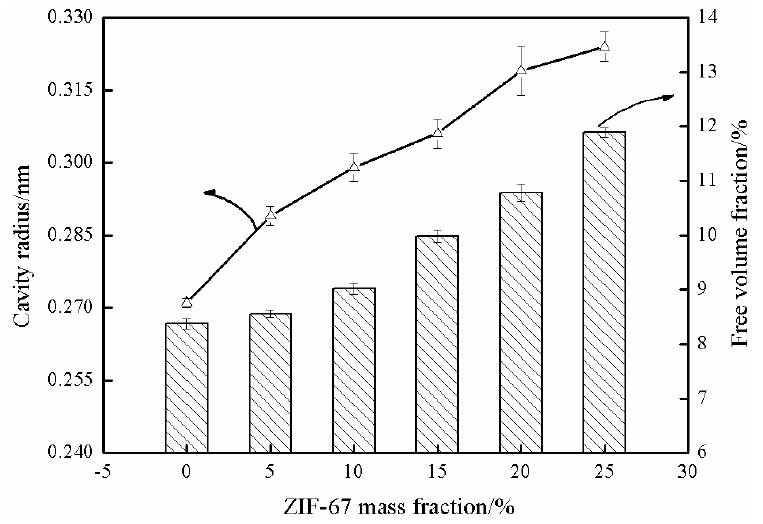
Figure 10. Free volume parameters of mixed matrix membranes.